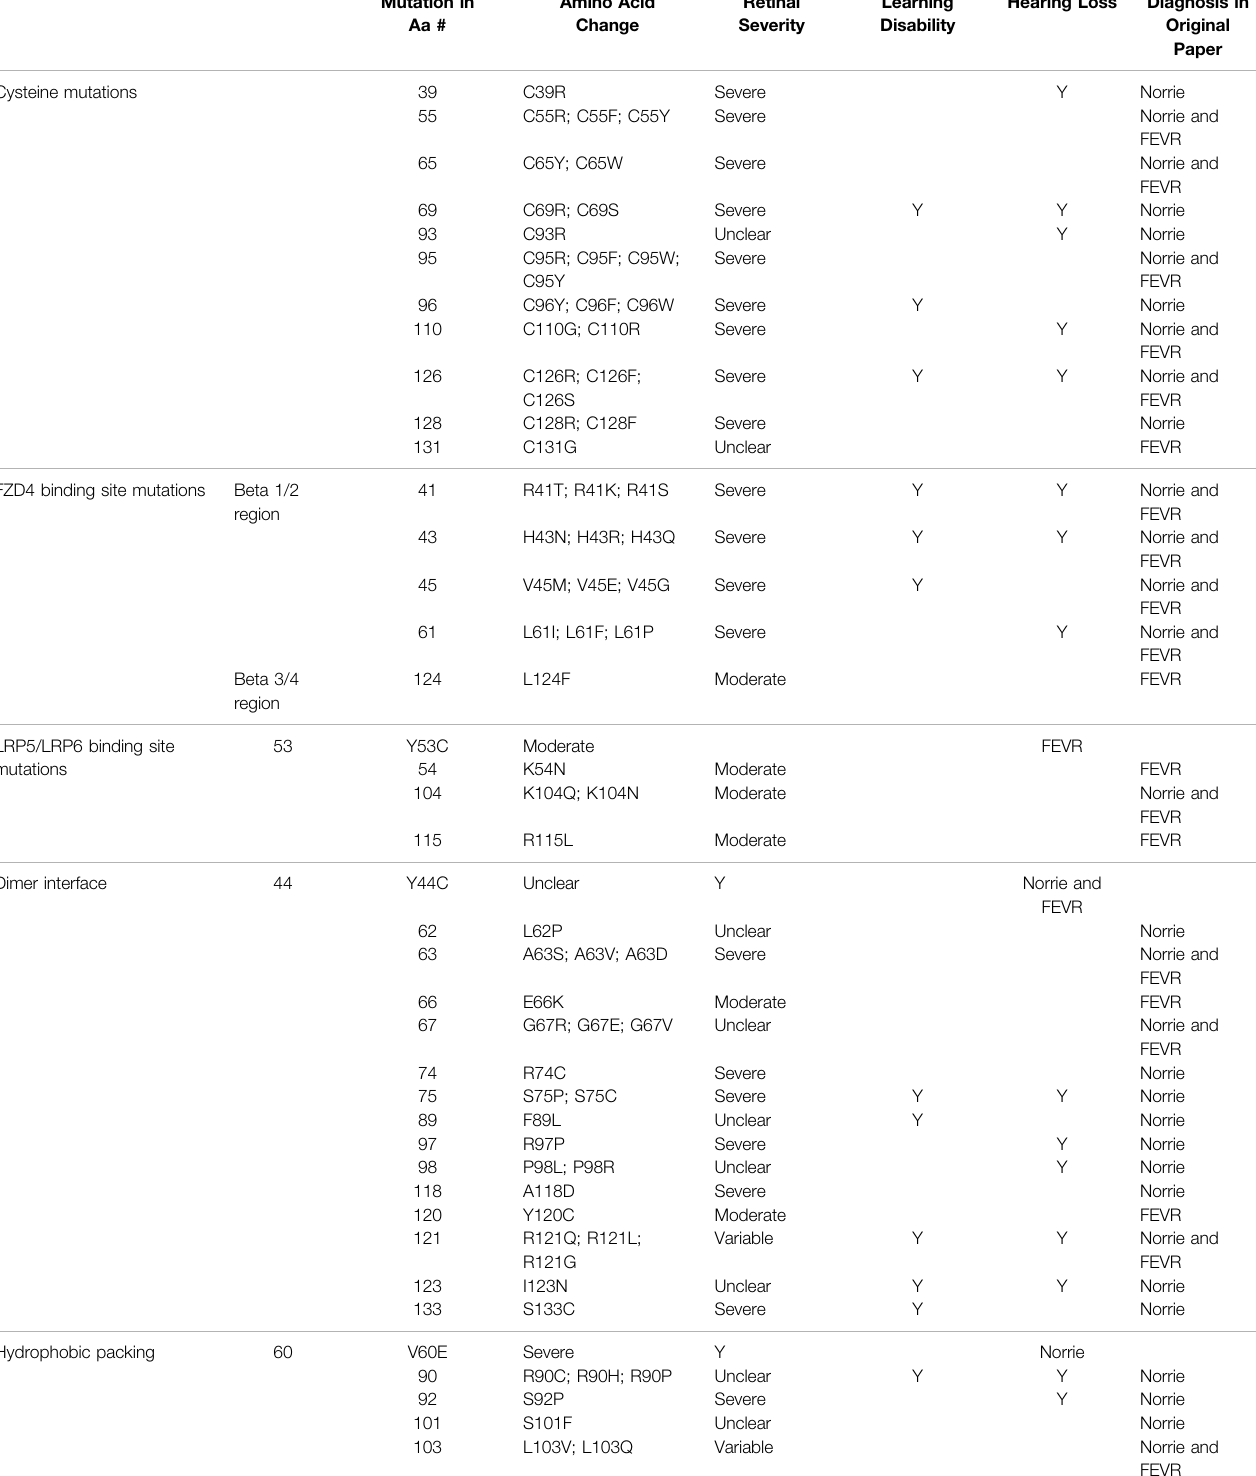
TABLE4| MissensemutationswithintheNDPcodingDNAwereclassi fi edbythefunctionalregionoftheNDPproteinaffected.Thetableshowstherelationshipbetweenthe regionofmissensevariantsandtheirresultingpathology.Mutationsarelistedinorderofaminoacidresiduenumber(aa#).Theseverityofretinaldiseaseaccordingtothe classi fi cation system described in the methods is recorded along with the presence or absence of hearing loss and intellectual disability. The diagnoses of FEVR, Norrie disease, or both FEVR and Norrie disease (as stated by the authors of the case reports of mutations in each amino acid residue) are